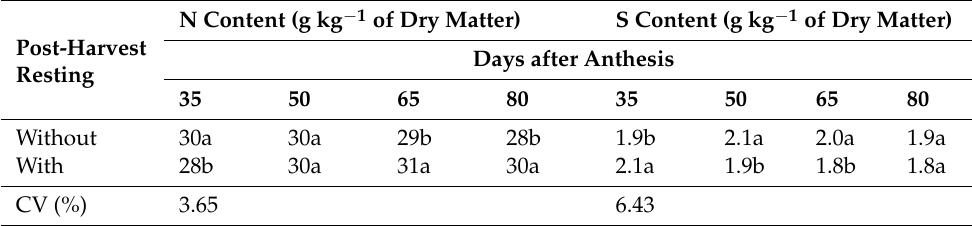
Table 2. Nitrogen (N) and sulfur (S) content of sweet pepper seeds without and with post-harvest resting of fruits at each maturation